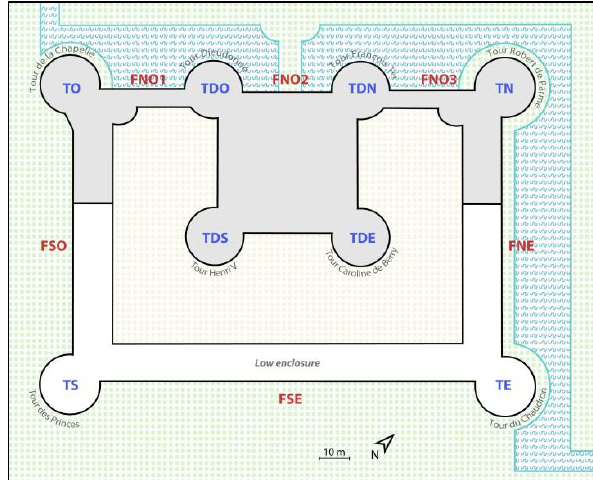
Figure 5: Working document with short names for each entity to be surveyed The outer surrounding wall of the castle is about 600 m long: 8.5 m high for the lower part (see the white areas in Figure 5) and about 20 m high to the roof base for the upper part (see the grey areas in Figure 5). The objective of the image acquisition is to be able to produce orthoimages of the six façades (FSO, FNO1, FNO2, FNO3, FNE & FSE) and unwrapped images of the six towers (TDS and TDE were not